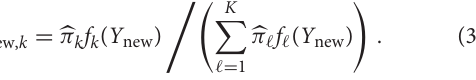
2 intercept (labeled 0) and regression coefficients for the four covariates and the 30 species; cor( = µ ), correlation matrix of the predicted log-abundances; cor( b b